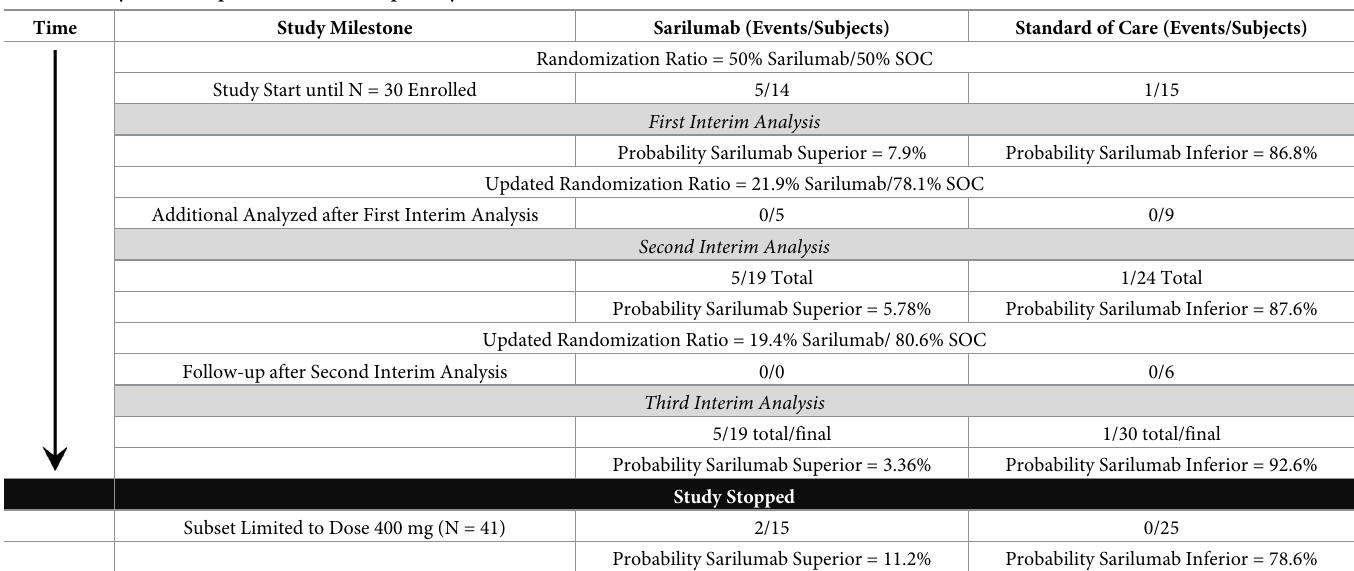
Table 5. Analysis and adaptation based on the primary